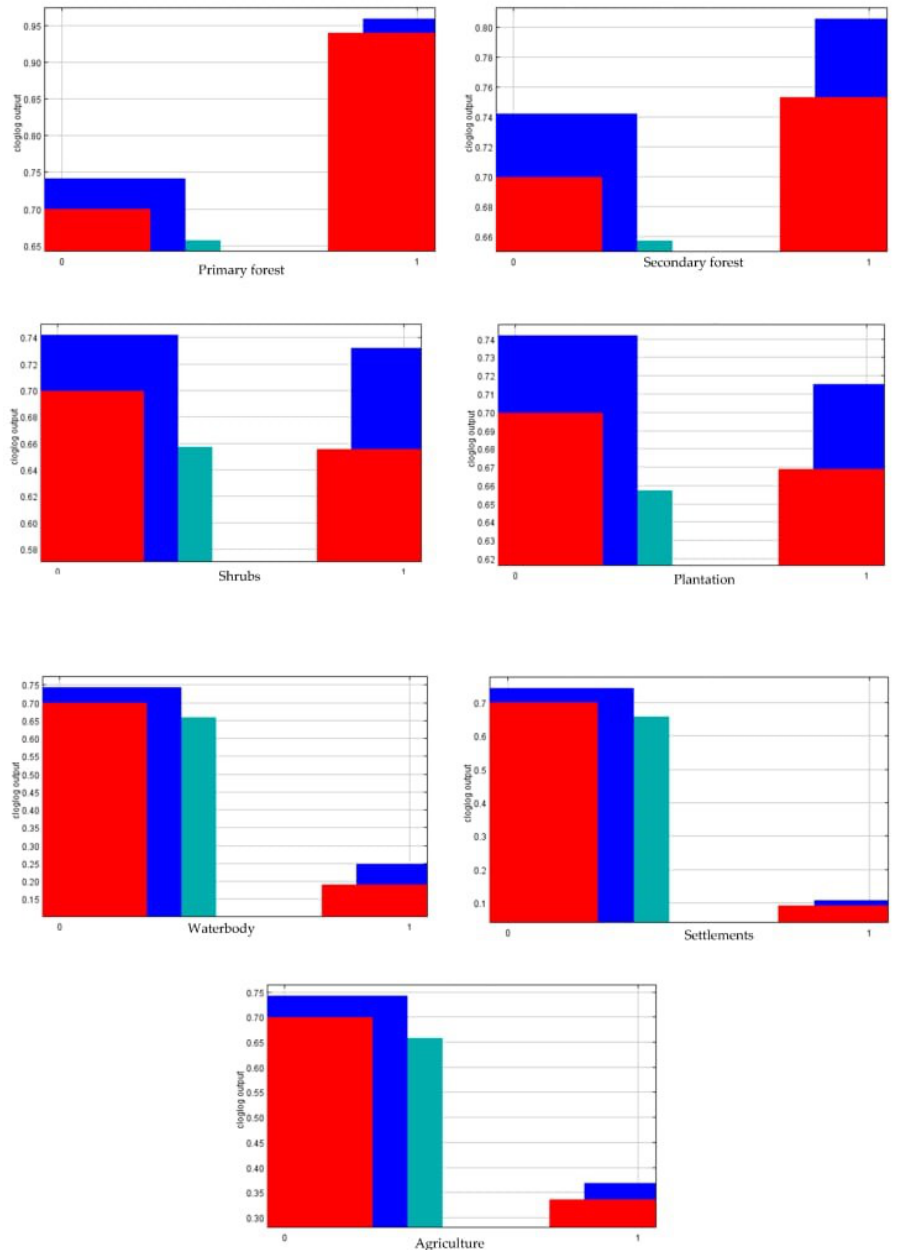
Figure 5. Response curve for the variable land cover with other variables.